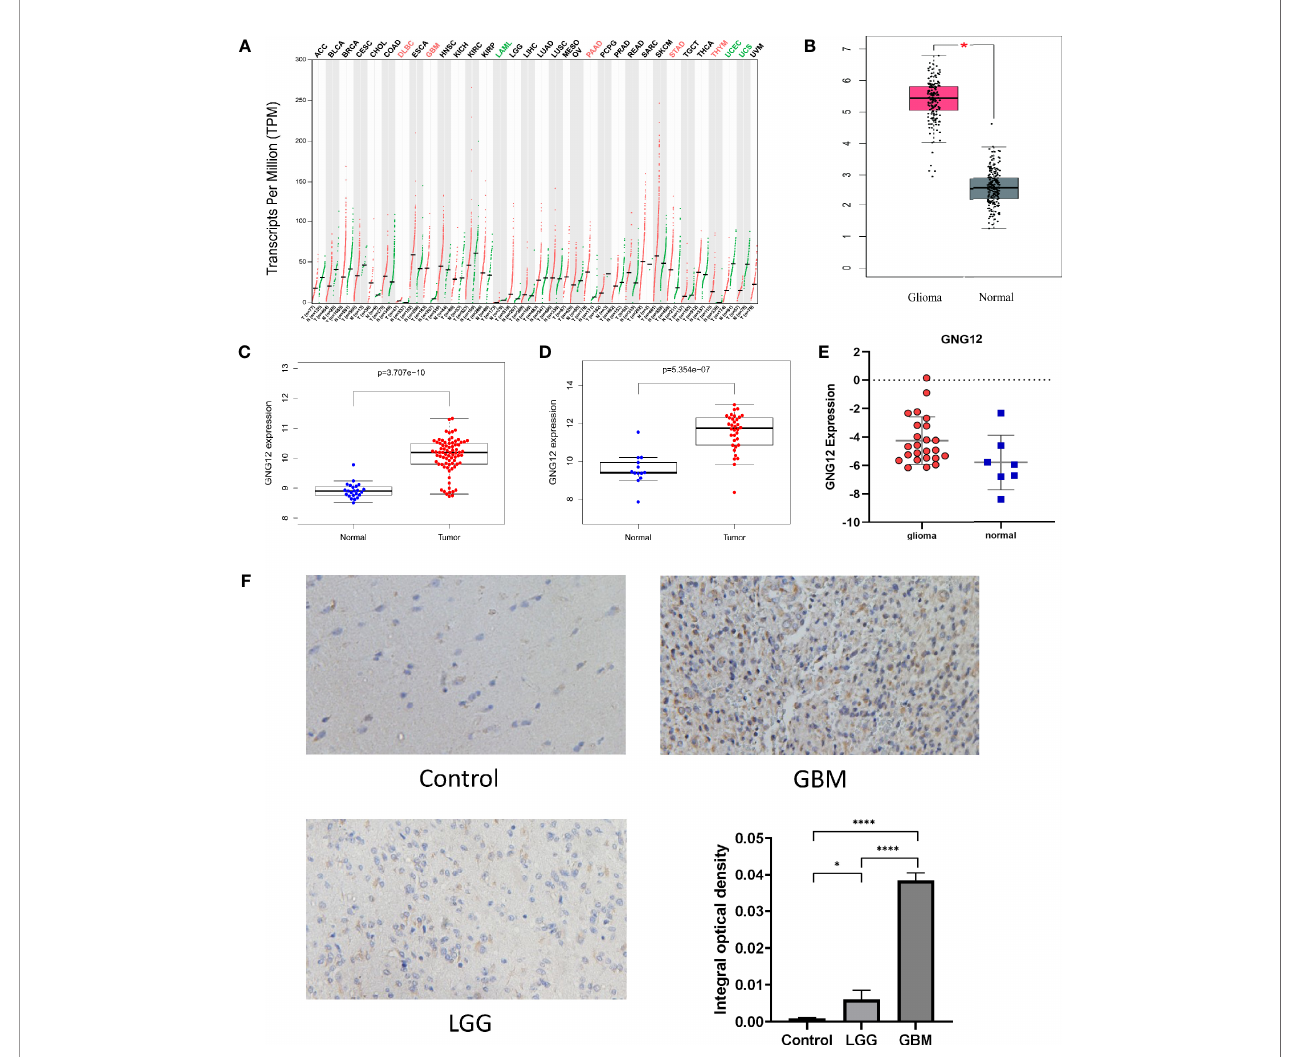
FIGURE 1 | The expression of GNG12 at different levels (mRNA, protein, gene microarray and gene sequencing) in gliomas. (A) The expression of GNG12 in different types of tumor tissues in the GEPIA, the expression of GNG12 in glioma (n=163) and normal brain tissue (n=207), red and green respectively represent the difference in expression level. Green means that the gene is under-expressed in tumor tissues, and the red means the gene is highly expressed in tumor tissues. (B) In the GEPIA database, the expression of GNG12 is different in glioma and normal brain tissue. (C) Box plot based on the expression level of GNG12 in the GSE4290 (Glioma=77, Normal=23). (D) Box plot based on the expression level of GNG12 in the GSE50161(Glioma=34, Normal=13). (E) RT-qPCR experimental results show that the expression of GNG12 in gliomas is higher than that in normal tissues. (F) Results of immunohistochemical experiments in normal brain tissue, low-grade glioma and glioblastoma and statistical analysis (Magni fi cation: *400). (****P<0.0001, *P<0.05)